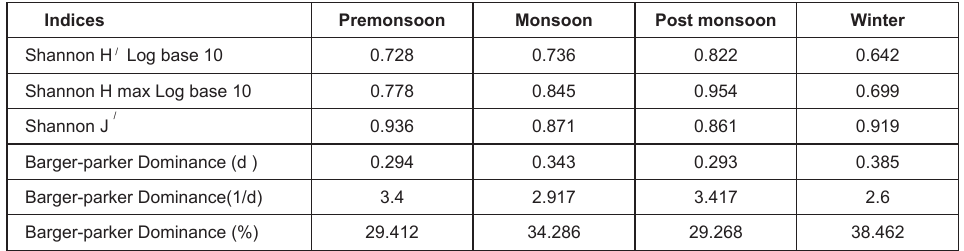
Table 1. Diversity Indices of Hemiptera in four different seasons